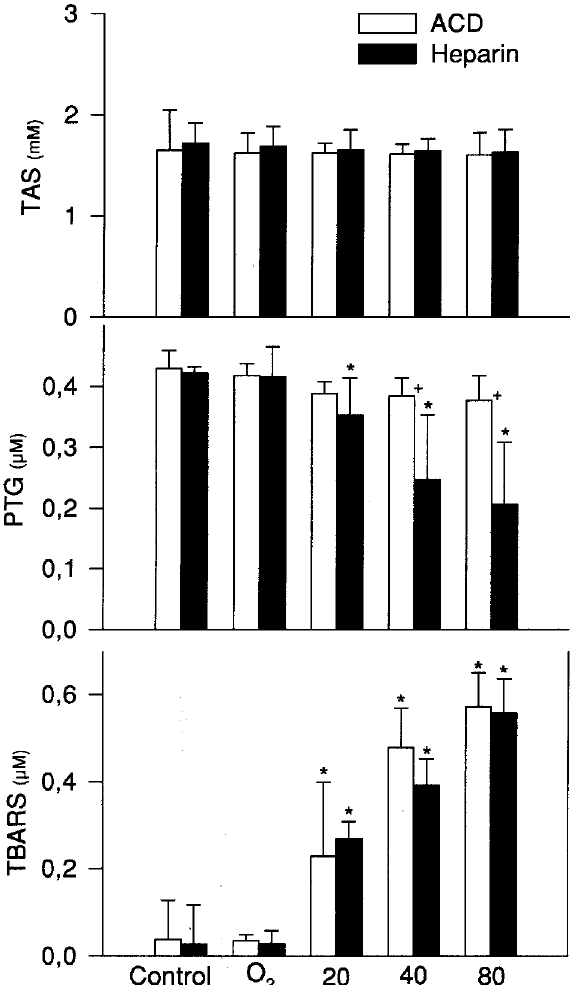
FIG. 1. Effect of 30sec exposure of either O 2 or O 2 –O 3 (20, 40 and 80 m g/ml perml of plasma) on total antioxidant status (TAS), protein thiol group (PTG) and thiobarbituric acid reactive substances (TBARS) of the same human platelet rich plasma samples collected either in heparin or in ACD. The statistical significance has been indicated with a (*) for intergroup and with a (+) for intragroup